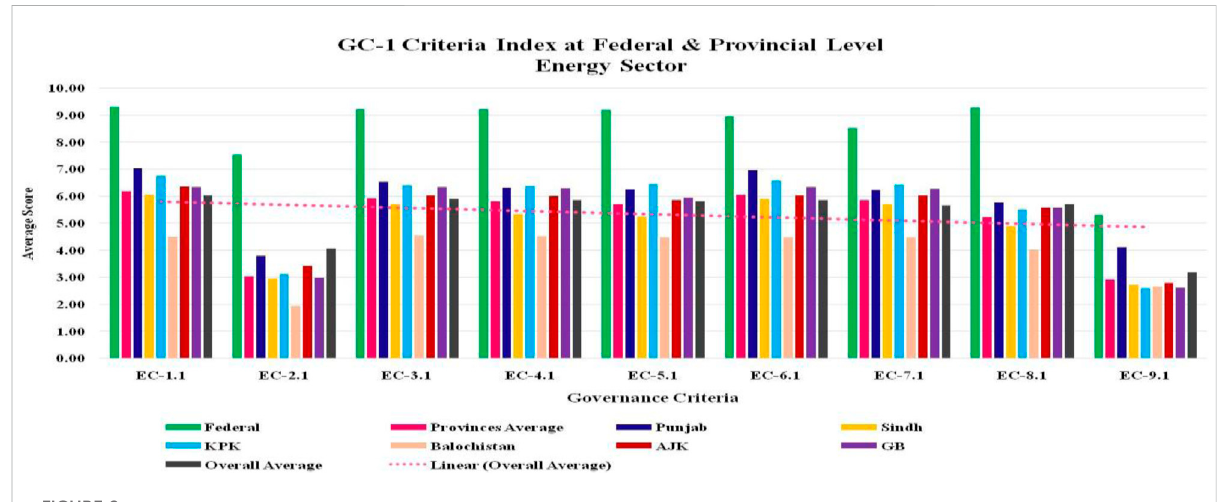
FIGURE 2 Criteria wise governance index for Governance Component-1 at provincial and federal